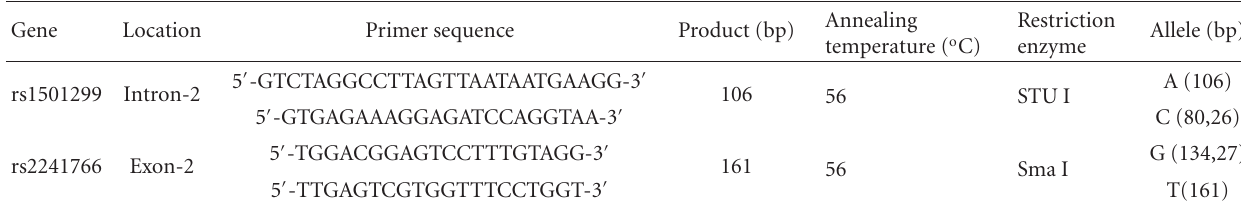
Table 1: Primer sequences and reaction conditions for genotyping adiponectin polymorphisms.